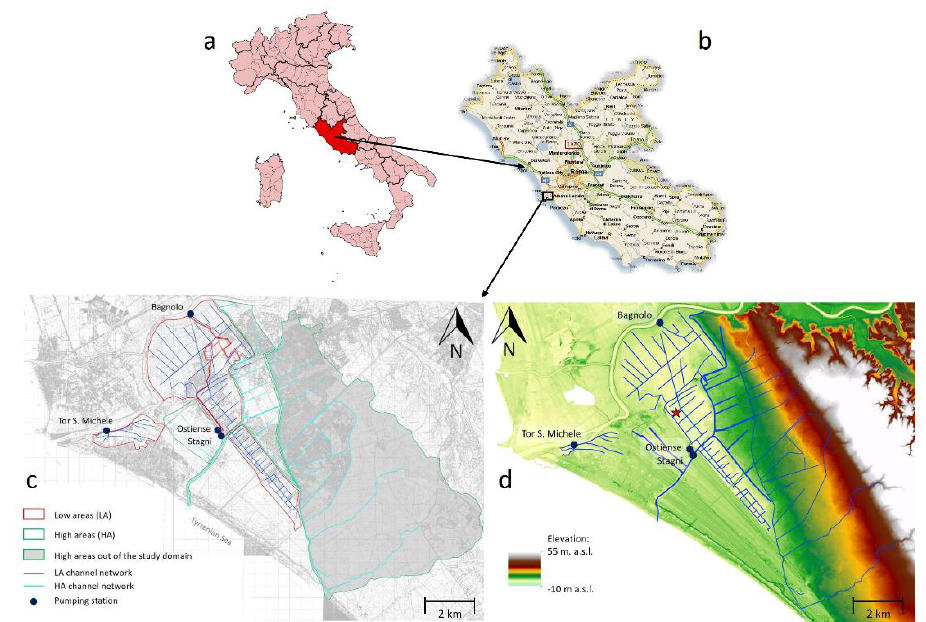
Figure 1. The study area ( c ), with its location within the Italian territory ( a ) and the Lazio region ( b ); the high and low areas and their drainage networks are represented by solid lines; the dots display the dewatering pumping stations. The shaded high areas were studied and modeled in a previous work [24]. The topography of the study area ( d ) clearly shows the zones with elevation below sea level. The red star in panel ( d ) is the center position of the sub-area represented in Figure 6.